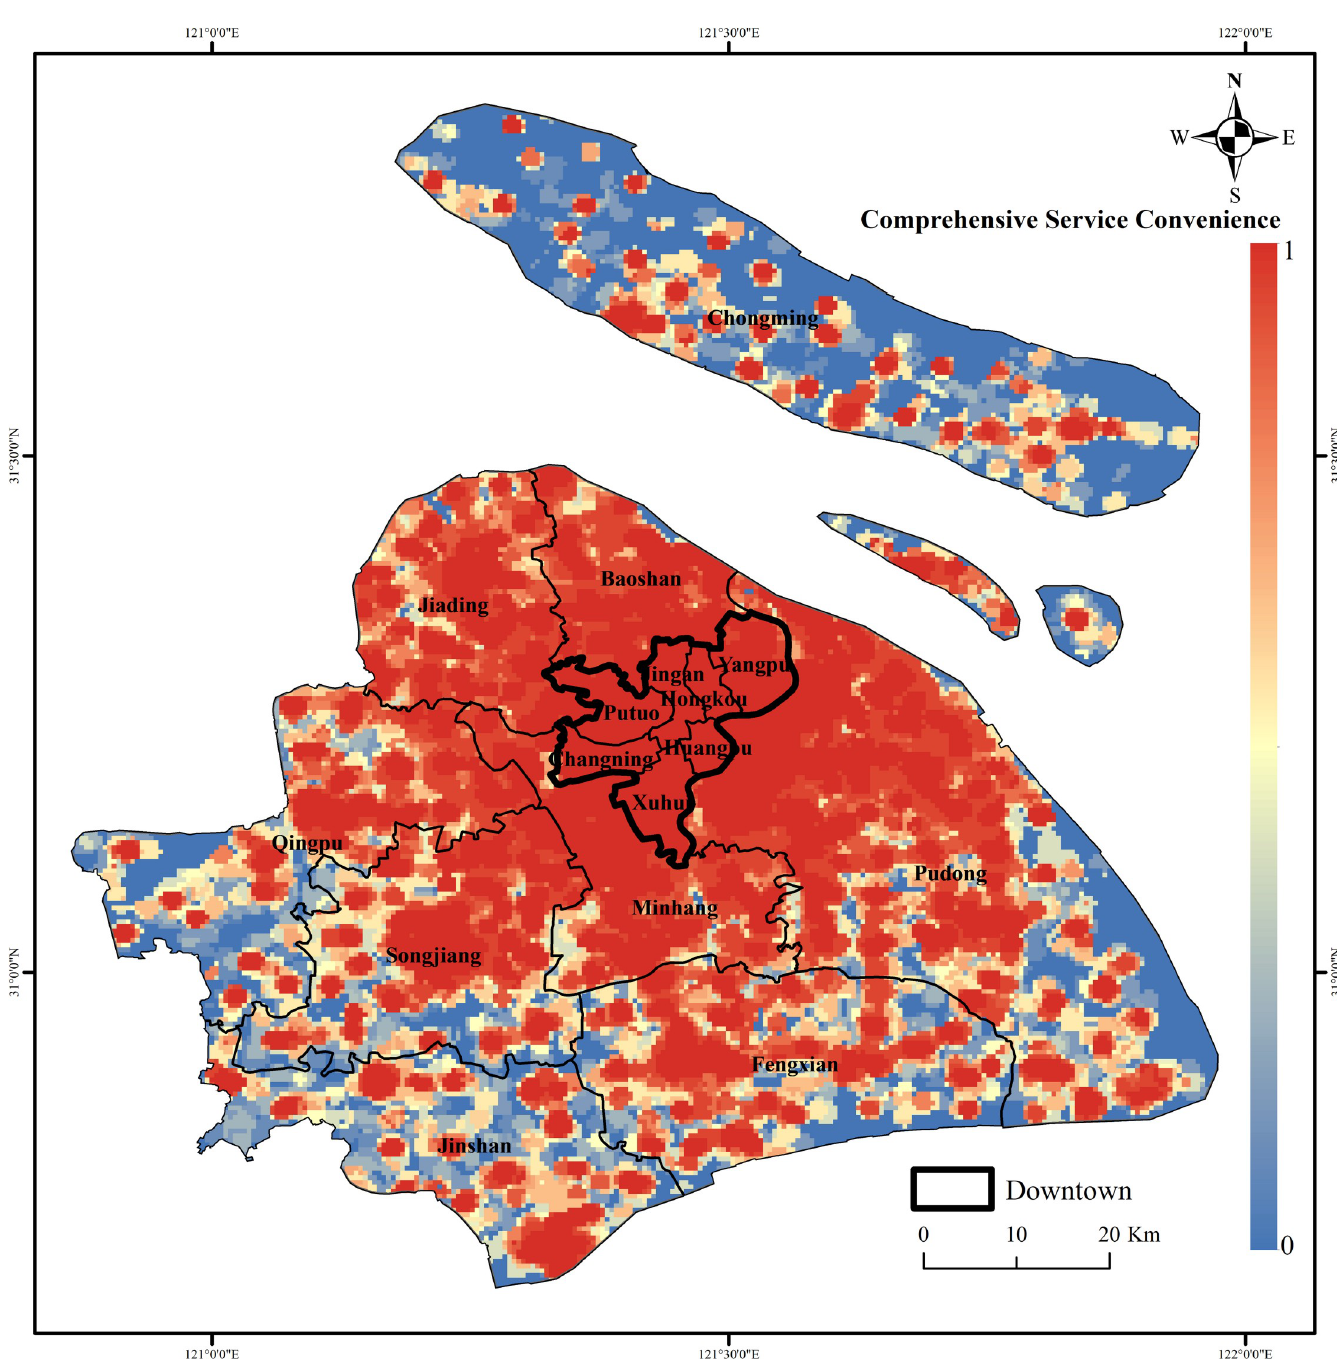
Fig 5. Distribution of mixed accessibility of basic service facilities in the 15min-CLC in Shanghai. (Image Source: https://www.naturalearthdata.com/downloads/ 10m-cultural-vectors/).